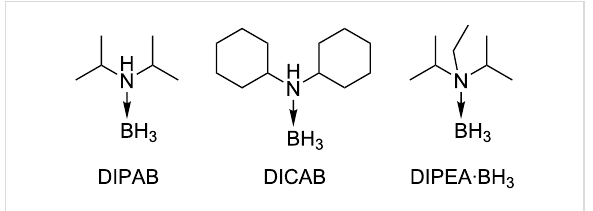
Figure 1: Structures and acronyms of the amine-borane complexes in- vestigated.